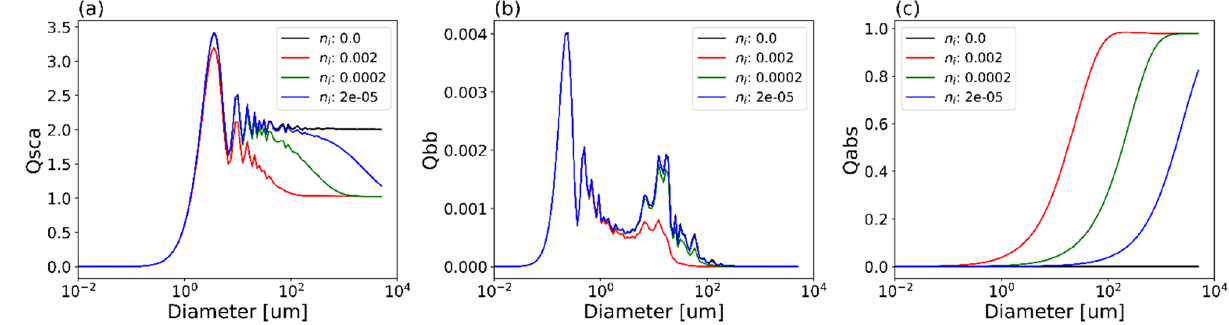
Figure 3. Increasing the imaginary refractive index ( n i ) reduces efficiency factors for ( a ) scattering, and ( b ) backscattering for particle sizes greater than 1–10 μm. ( c ) Increasing n i results in particles achieving saturation efficiency (close to an absorption efficiency of 1) at smaller